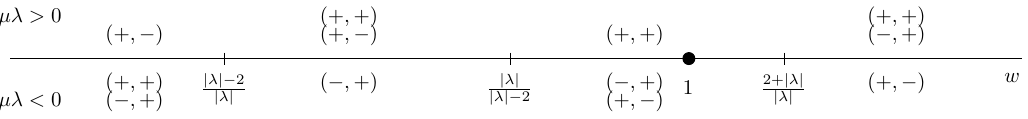
Figure 2. The vacuum structure of the N = 1 theory (1.8) as a function of the parameter w . The two cases sgn( (cid:22) ) = (cid:6) sgn( (cid:21) ) are given above and below the w line respectively. The quantum e(cid:11)ective potential either has one or two N = 1 supersymmetric vacua for a given range of w and sign of (cid:22)(cid:21) . In the cases where there are two such vacua, we have indicated both in the above phase diagram. The w = 1 point corresponds to the N = 2